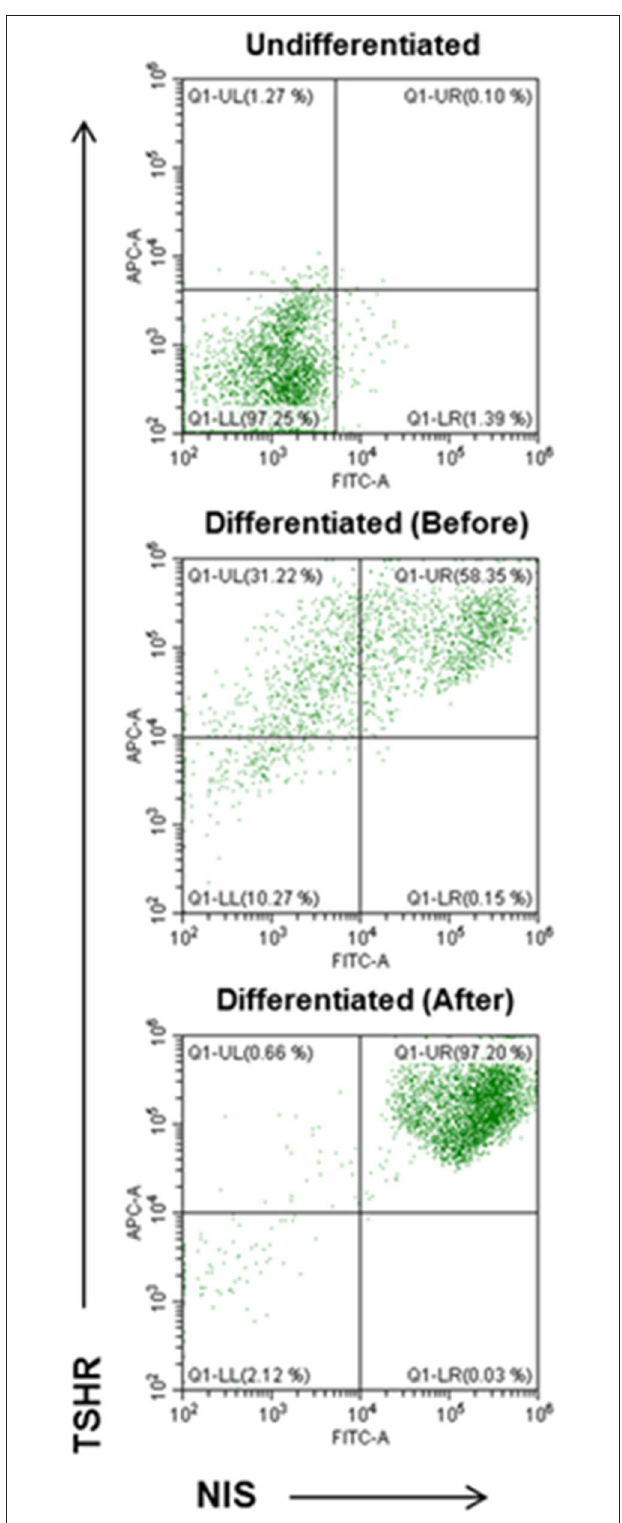
FIGURE 7 | FACS analysis of TSHR and NIS expression in differentiated thyroid cells. Undifferentiated LF cells (upper), differentiated LF cells at 21 days (middle) (58.35% double positive), and purified differentiated LF cells (lower) (97.20% positive) analyzed for double anti-NIS and ant-TSHR staining after sorting